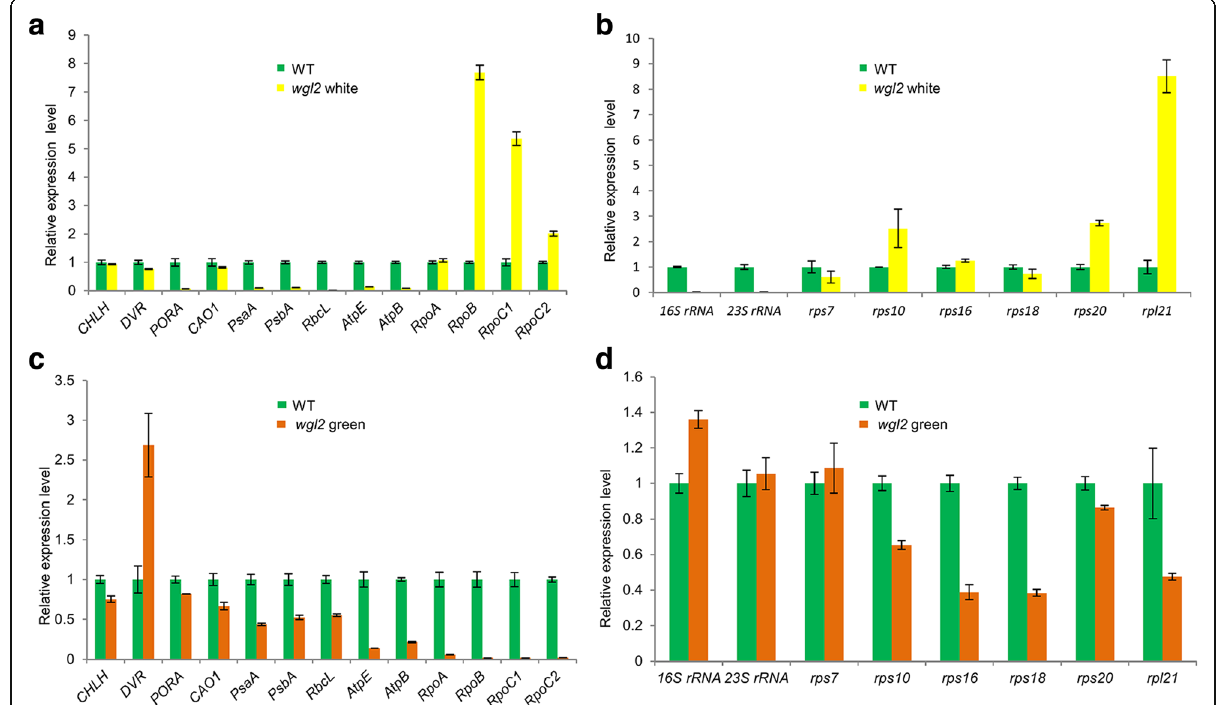
Fig. 8 Expression of genes associated with Chl biosynthesis, photosynthesis, chloroplast development, and ribosome development in the wgl2 mutant and wild type. a , c Expression of genes associated with Chl biosynthesis, photosynthesis, chloroplast development in WT and wgl2 white seedlings ( a ), and in WT and wgl2 green plants ( c ). b , d Expression of genes associated with ribosome development in WT and wgl2 white seedlings ( b ), and in WT and wgl2 green plants ( d ). The relative expression level of each gene was normalized using UBQ5 as an internal control. The expression level of each gene in WT was set to 1.0 and other samples were calculated accordingly. Values represent the mean ± SD of 3 biological